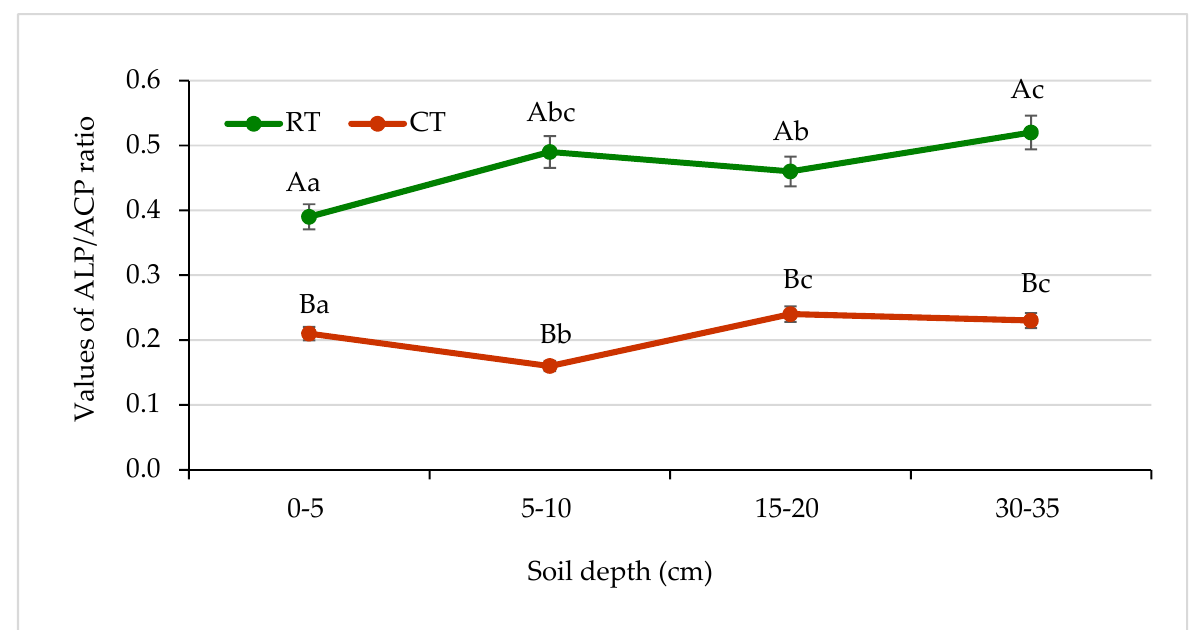
Figure 13. Changes in alkaline phosphatase (ALP) and acid phosphatase (ALP) activities ratio in soil under different tillage systems in 2018–2020 (expressed as means for the 3 years, n = 12). Different letters represent significant differences ( p ≤ 0.05) across treatments according to Tukey’s HSD test; lowercase letters within the same tillage system indicate significant differences between soil depths; uppercase letters indicate differences between tillage systems. RT—reduced tillage system; CT—conventional tillage system; d.w.—dry weight of soil; n —number of samples. Vertical bars represent standard errors. Table 2. Effects of different tillage systems on stratification ratios of summarized labile